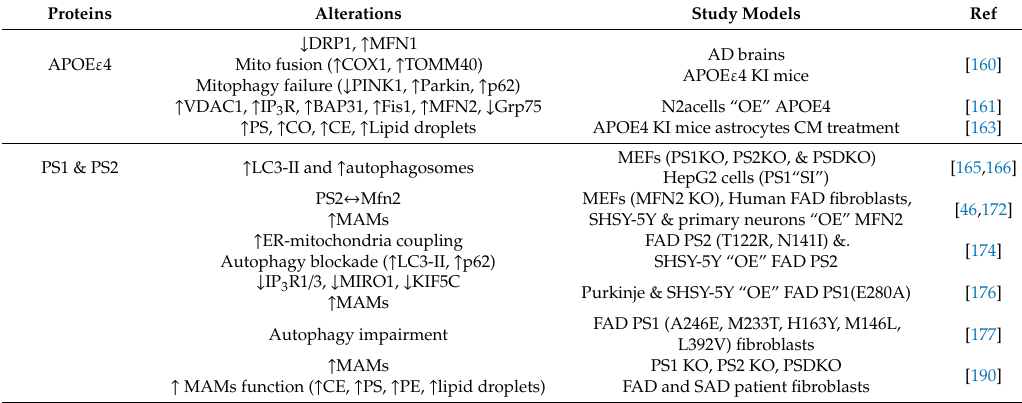
Figure 3. APP and its derived fragments APP-CTFs and A β ; presenilins (PSs), pTau and APOE4 are involved in the impairment of the expression and activity of several mitochondrial proteins (highlighted in red) and interfere with UPR in the ER. APP localizes and is processed by β - and γ -secretases in MAMs. AD Molecular partners also disturb MAMs structure and function. Table 2. Alterations of mitochondria- and MAMs-structure and functions associated with AD-related proteins. These alterations include: ↓ reduced or ↑ increased expression / activity, ↔ interaction observed in AD study models (cells and mice brains) and human derived samples (SAD brains and SAD / FAD fibroblasts). Mito: mitochondria, KO: knock-out; PSDKO: PS1 and PS2 double KO; KI: knock-in; “SI”: silencing; “OE”: overexpressing; PS: phosphatidylserine; CO: cholesterol oleate; CE: cholesterol ester; CM: conditioned media, WT: wild type; CGC: cerebellar granule cells; ROS: reactive oxygen